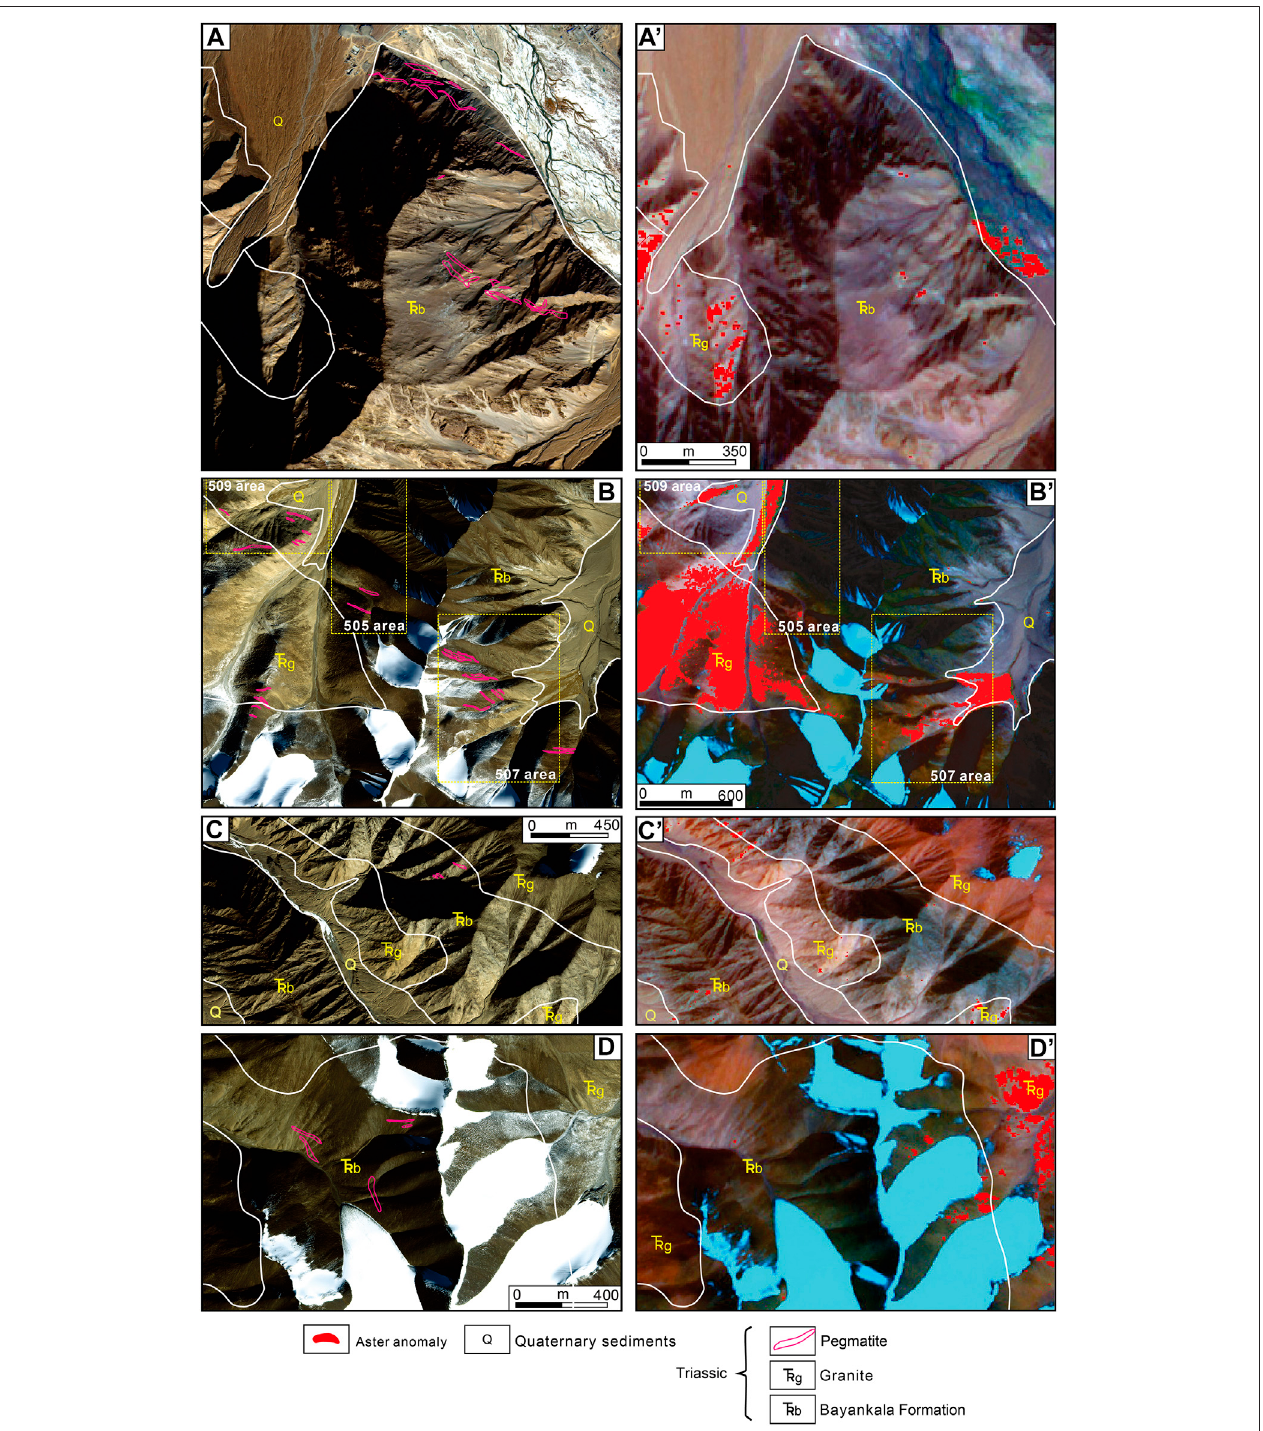
FIGURE 4 | Remote sensing images of the Aktas, 505, 507, and South Fulugou 1# and 2# Li deposits: (A, A 9 ) Worldview-2 image and Aster image of the Aktas Li deposit; (B, B 9 ) Worldview-2 image and Aster image of the 505 and 507 Li deposits; (C, C 9 ) Worldview-2 image and Aster image of the South Fulugou 1# Li deposit; (D, D 9 ) Worldview-2 image and Aster image of the South Fulugou 2# Li deposit.